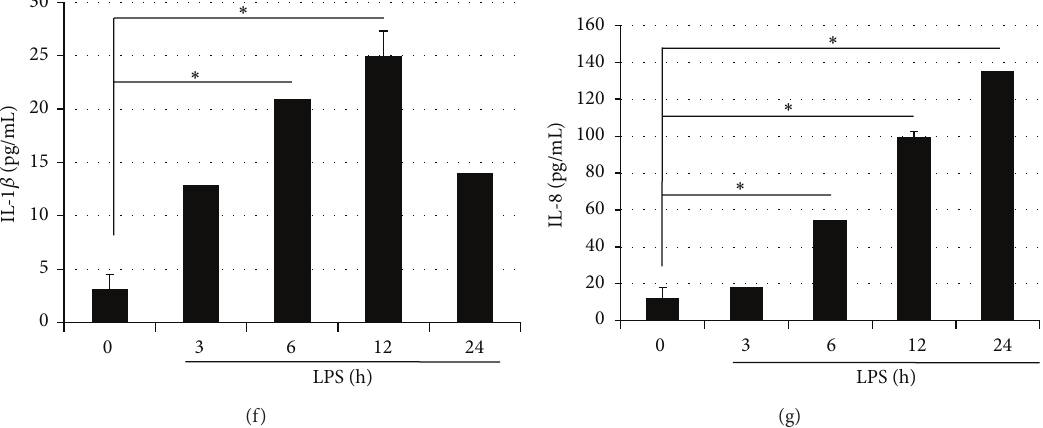
Figure 3: LPS upregulated RAGE expression and proinflammatory cytokines release in OLC-1 culture. (a) Cells were stimulated with LPS as indicated for 6h. The expression of RAGE was examined by quantitative real-time PCR. (b) Cells were stimulated with LPS for 24 h, and RAGE protein was examined by western blot analysis. A representative blot using antibodies against RAGE and 𝛽 -actin is shown. RAGE expression was quantified by densitometry and normalized to 𝛽 -actin. (c) Increased RAGE surface expression by OLC-1 cells following LPS stimulation for 12h was analyzed by flow cytometry. A representative histogram is shown. (d) Active release of HMGB1 in a time-dependent manner upon stimulation with 100ng/mL LPS. (e) HMGB1 release in a dose-dependent manner after LPS stimulation for 24 h. IL-1 𝛽 (f) and IL-8 (g) release in a time-dependent fashion following LPS stimulation. Results are expressed as the means ± SD from triplicate experiments. ∗ 𝑃< 0.05 , ∗∗ 𝑃< 0.001 . cells) and gradually increased at higher doses ( 𝑃 <